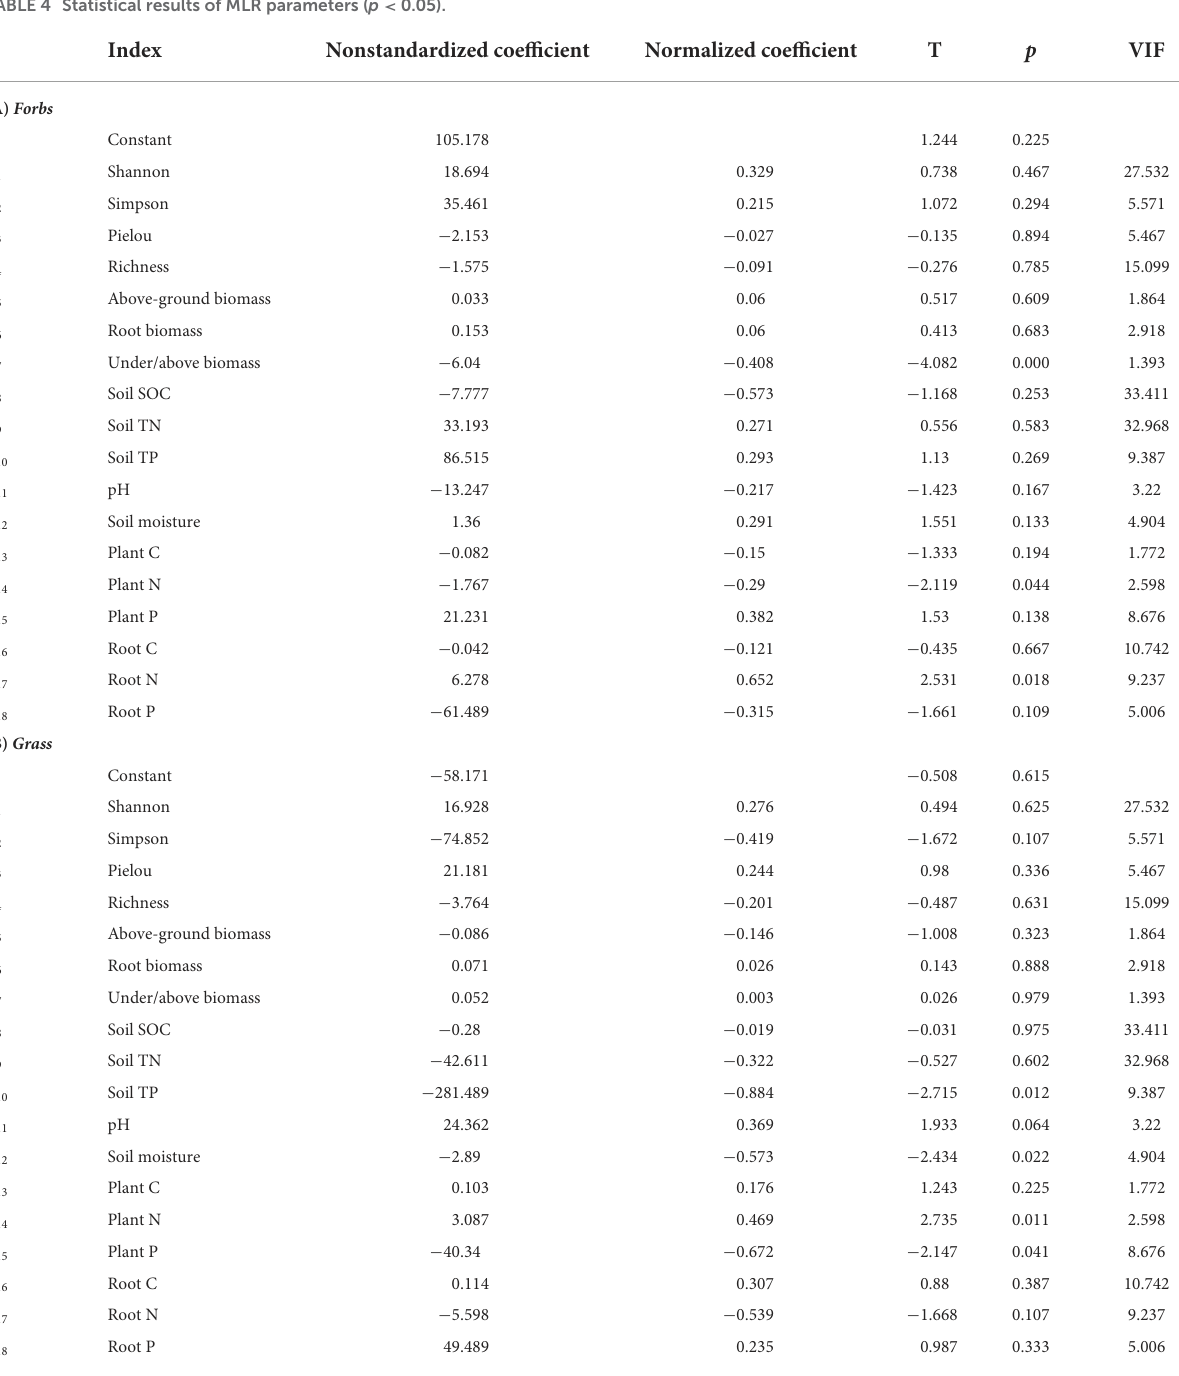
TABLE 4 Statistical results of MLR parameters ( p <